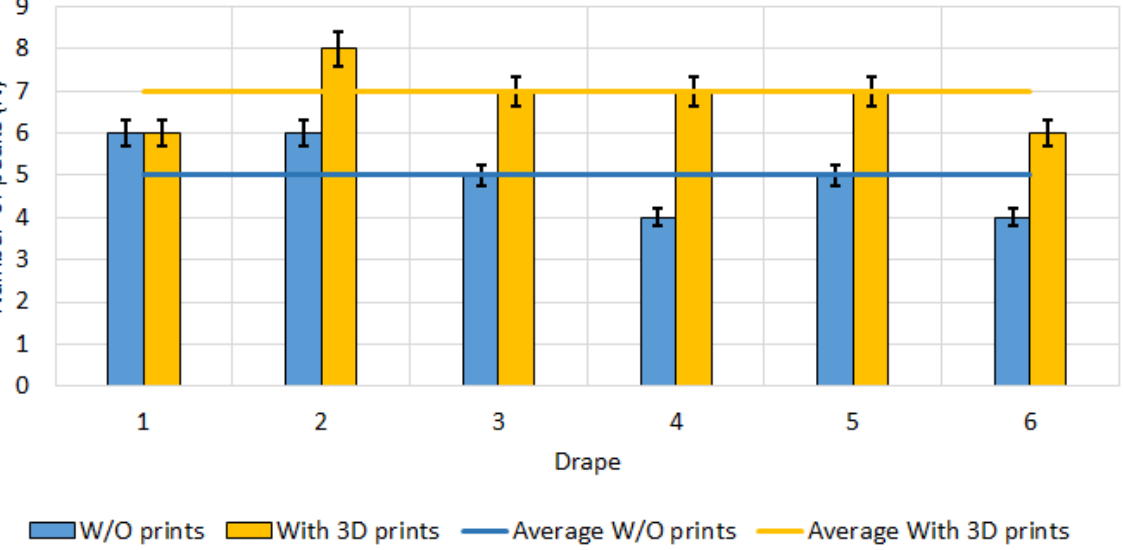
Figure 11. Comparison between obtained number of peaks for drapes with and without 3D printing (N). The values are significantly different at p < 0.05.